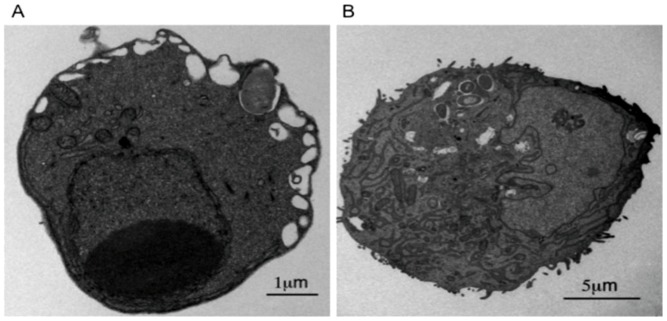
Electron microscope observations revealed details of internal organelles of undifferentiated and differentiated cells.Electron micrographs showing (A) undifferentiated ESC and (B) ESDC. Note the presence of intracellular S. Typhimurium in these images. Scale bars denote different sizes.